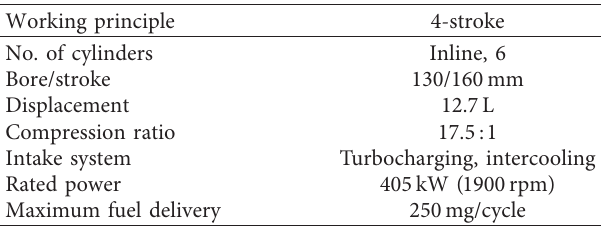
Figure 5: Comparison of control performance between control laws (41) and (42) under different conditions, i.e., (A) continuous control with control law 41, (B) timing control with control law (41), (C) timing control with control law (42) and h � 2 h . (a) Phase trajectories. (b) Convergence trajectories. with control law (42) and h 0 Table 1: Parameters of the target marine diesel